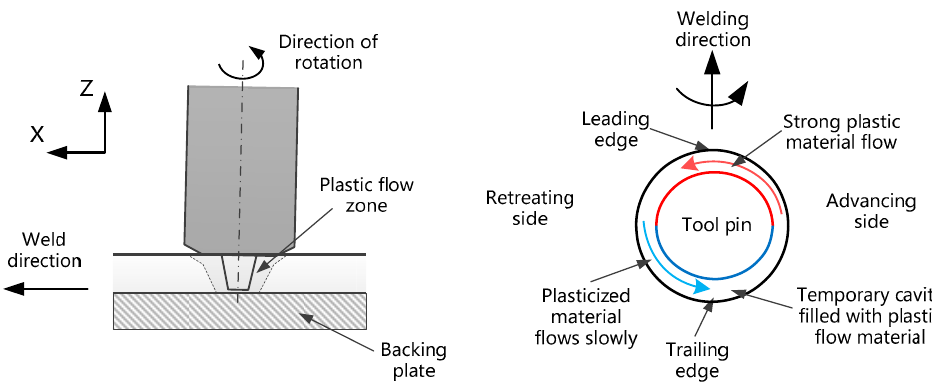
Figure 1. Schematic of the material movement around the friction stir welding (FWS) tool.